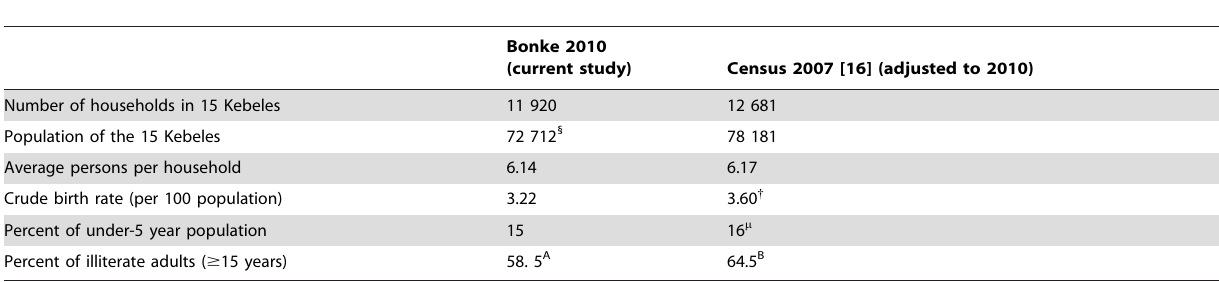
Table 1. Background information comparing study population with national census